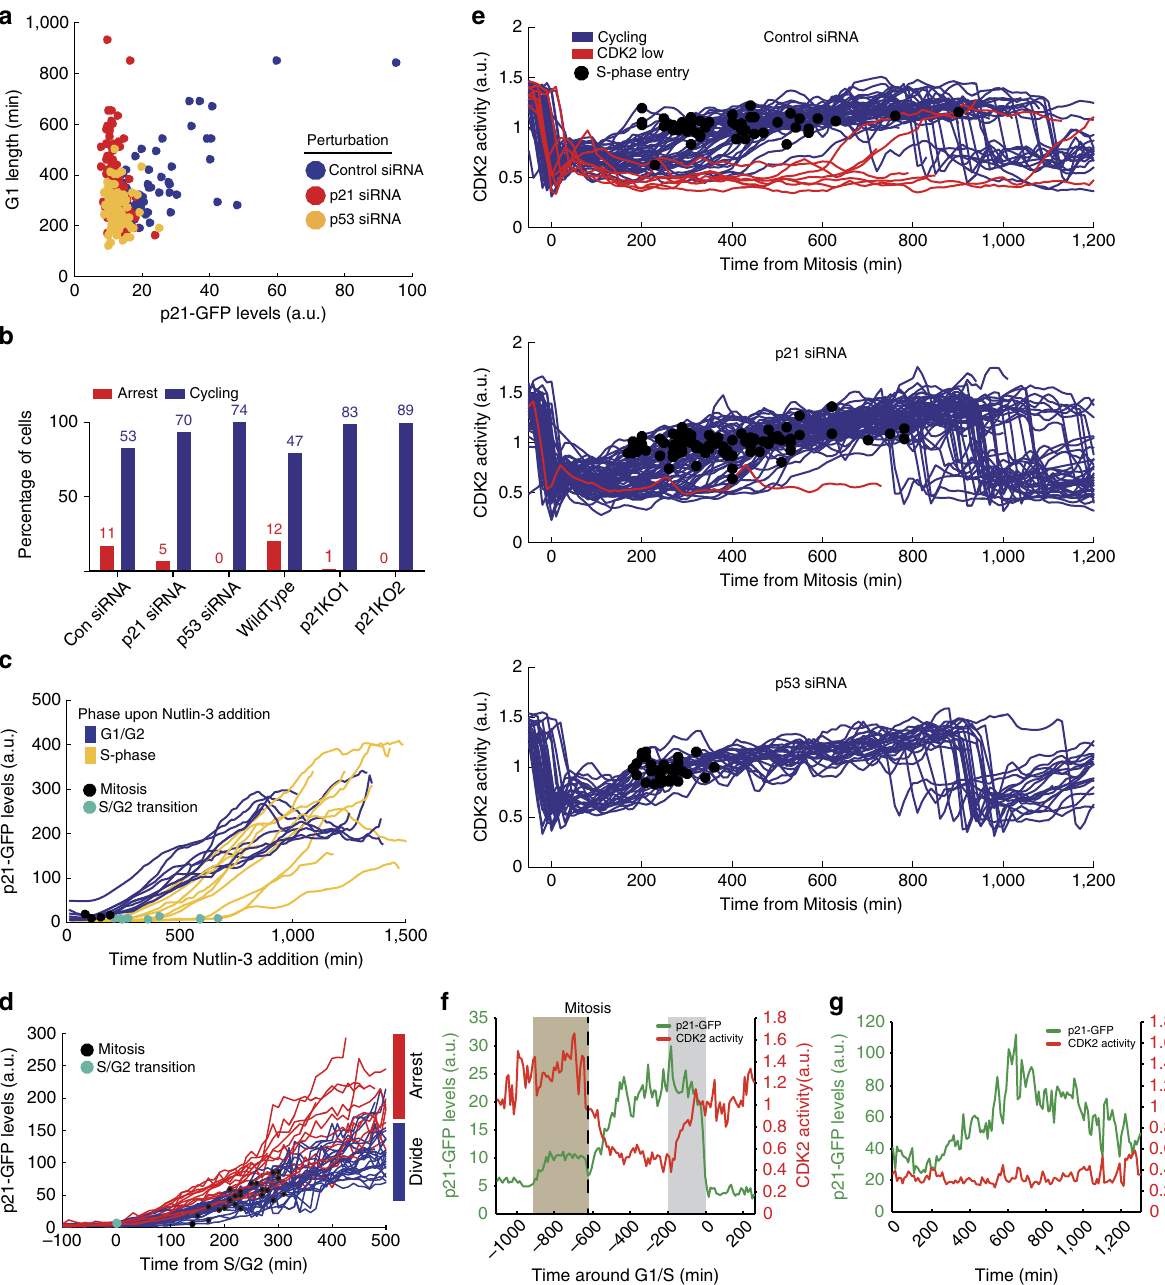
Figure 2 | p53 drives p21 heterogeneity in unperturbed conditions. ( a ) p21-GFP levels versus G1 length after siRNA treatment: control siRNA (blue), n ¼ 75 cells; p53 siRNA (yellow), n ¼ 81; or p21 siRNA (red), n ¼ 90. ( b ) Percentage of cells arresting in G1 for three siRNA treatments and for p21WT versus two p21KO clones. Number of cells is shown above each bar. Red bars represent cells that enter G1pm arrest, blue bars are cells that enter S-phase (cycle). ( c ) Single-cell traces of p21-GFP levels after 5 m M Nutlin-3 addition: S-phase on addition, yellow, n ¼ 8 cells; G1 on addition, blue, n ¼ 8. Time of mitosis is marked by black circles and time of S-phase entry is marked by blue circles on each single-cell trace. ( d ) Effect of rate of p21-GFP accumulation on G2 entry after Nutlin-3 addition to cells in S-phase. Black circles represent mitosis. Arrest, red, n ¼ 19 cells; Mitosis, blue, n ¼ 28. ( e ) CDK2 activity profiles aligned to mitosis for: control siRNA, n ¼ 51 cells; p21 siRNA, n ¼ 68 cells; and p53 siRNA, n ¼ 25 cells. Red curves represent CDK2low cells. Black circles represent time of S-phase entry. ( f ) Single-cell trace of CDK2 activity and p21-GFP levels in an unperturbed cell. Brown shading is G2. Grey shading shows a period in G1 where CDK2 activity is increasing despite expression of p21-GFP. Traces aligned to S-phase entry at t ¼ 0min. p21-GFP levels are shown in green and CDK2 activity is shown in red. ( g ) Single-cell trace of CDK2 activity and p21-GFP levels in an unperturbed cell arrested in G1. p21-GFP levels are shown in green and CDK2 activity is shown in red. Note: different scale for p21-GFP y-axis compared to ( f